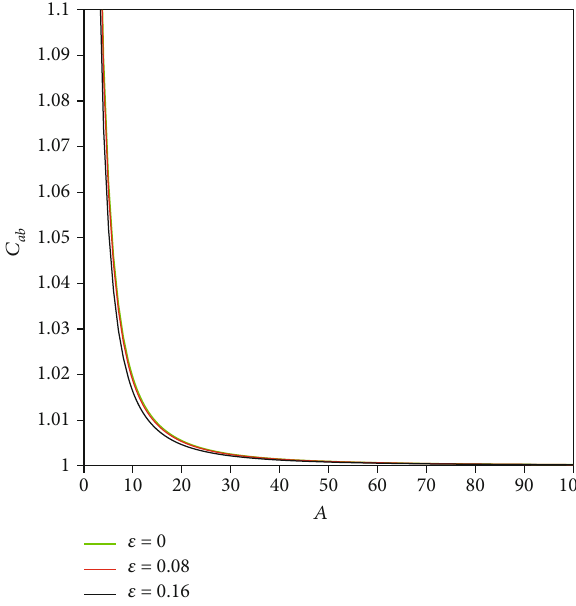
Figure 14: The steady state photon number correlation function of the two-mode cavity radiation versus x for κ = 0 : 8 , x = 0 , C ab and di ff erent values of ε .